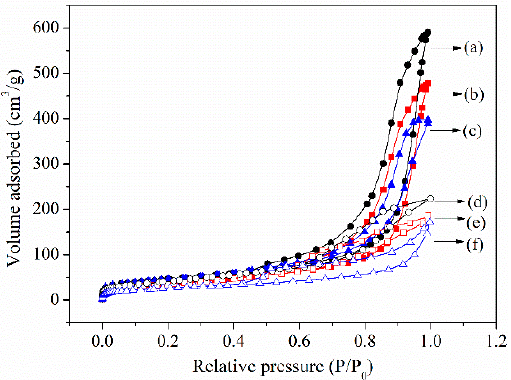
Figure 2. N 2 adsorption–desorption isotherms of (a) (b)